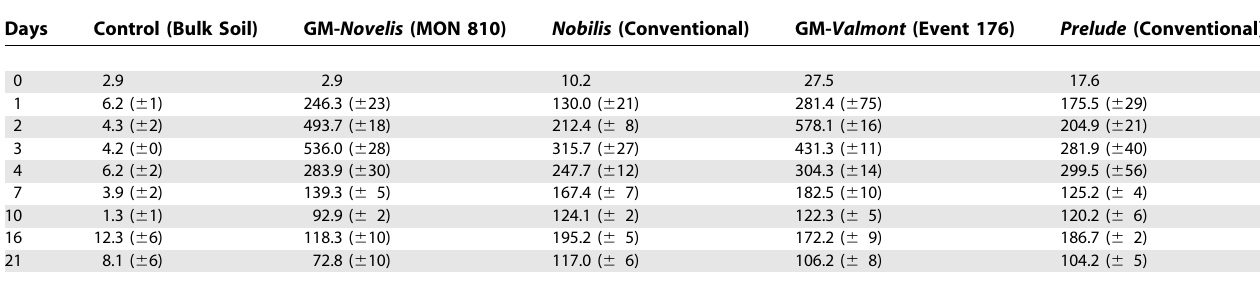
Table 1. Daily Respiration of Soils Amended with Straw from Different Cultivars of Maize ( l g CO 2 /g Dry Soil 6 SD) Whose Cultivars Show Strong Differences (ANOVA: p , 0.0002) Days Control (Bulk Soil)